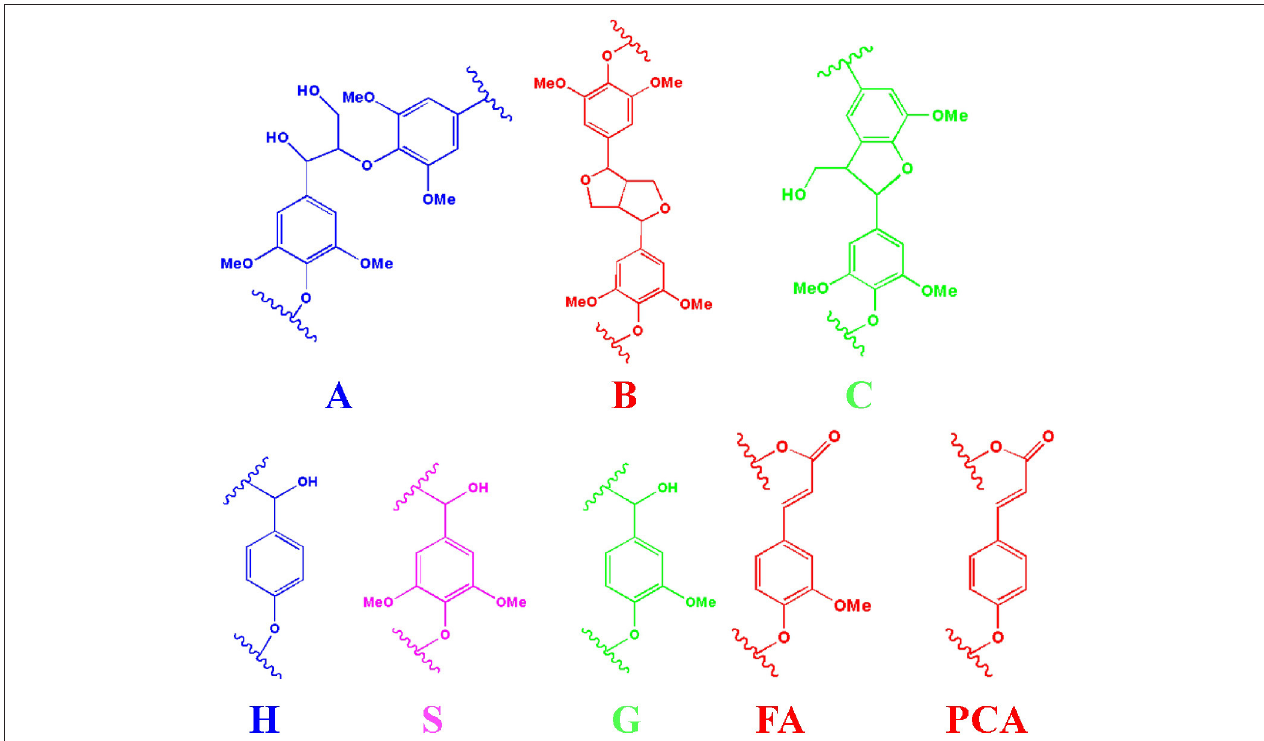
FIGURE 2 | The main substructures of lignin in the spectra (A: β -O-4 substructures; B: resinol substructures; C: phenylcoumaran substructures; H: p -hydroxyphenyl units; S: syringyl units; G: guaiacyl units; FA: ferulate; PCA: p -coumarate).